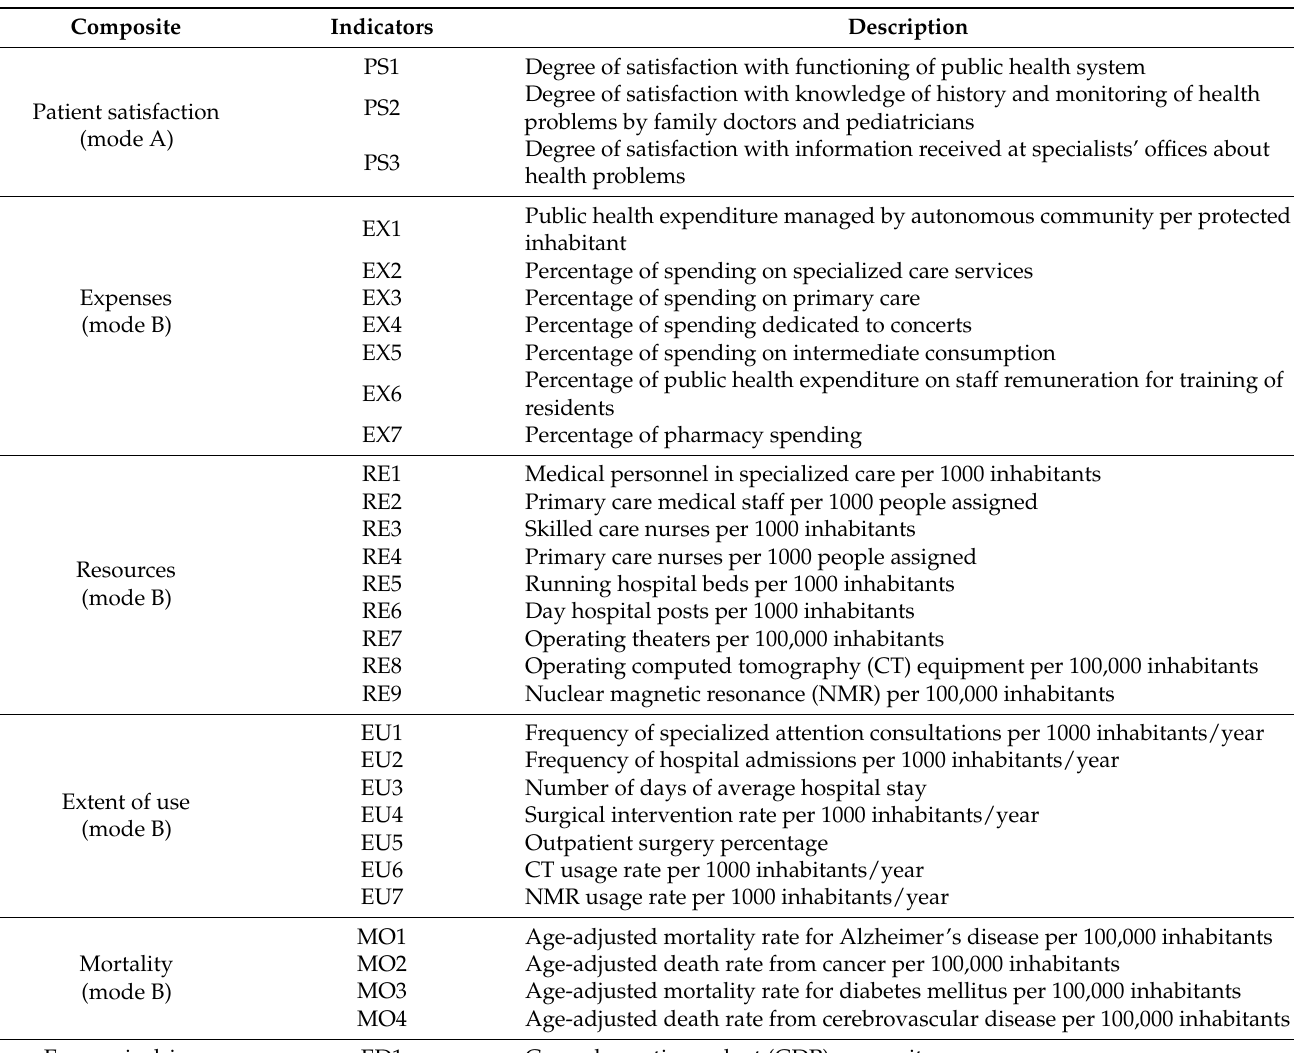
Table 1. Composites and descriptions of